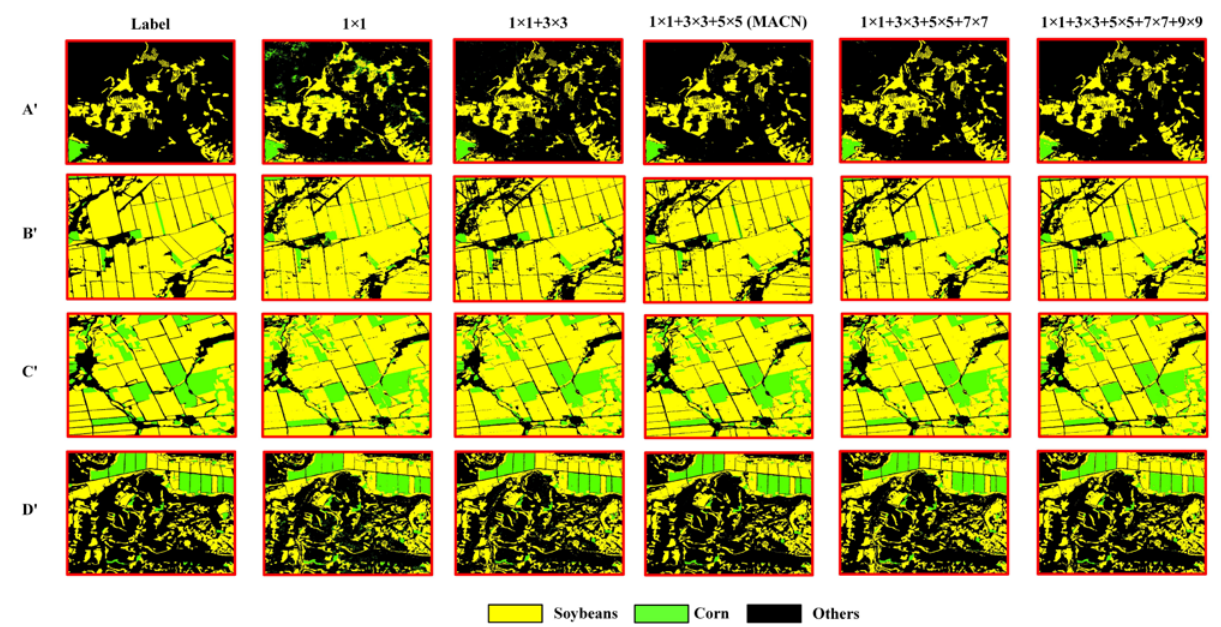
Figure 11. The classification results obtained from the different window sizes. The average accuracy scores of the networks at different scales for the four test areas are presented in Table 3. In terms of accuracy, the 1×1 window network also had the low- est accuracy evaluation metrics among all of the models. The OA and kappa coefficients were 0.9481 and 0.9115, respectively, when the window size was 5×5, which were the